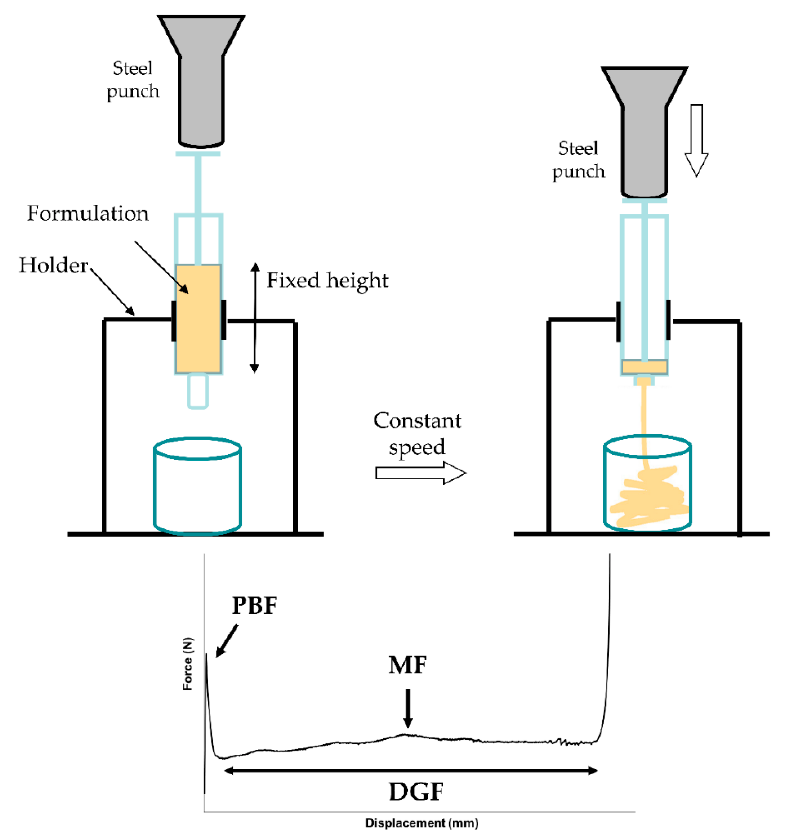
Figure 1. Syringeability test setting and a general force versus displacement curve (PBF: plunger-stopper break loose force; MF: Maximum force; DGF: Dynamic glide force).